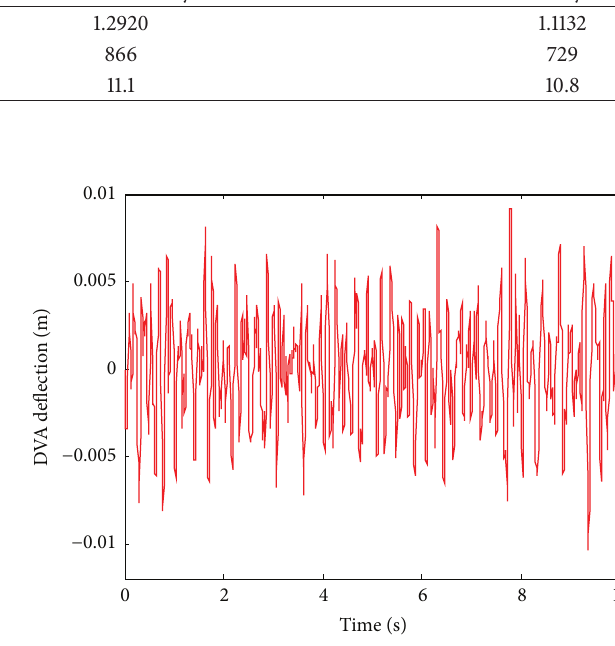
Figure 17: Motor deflection variation with